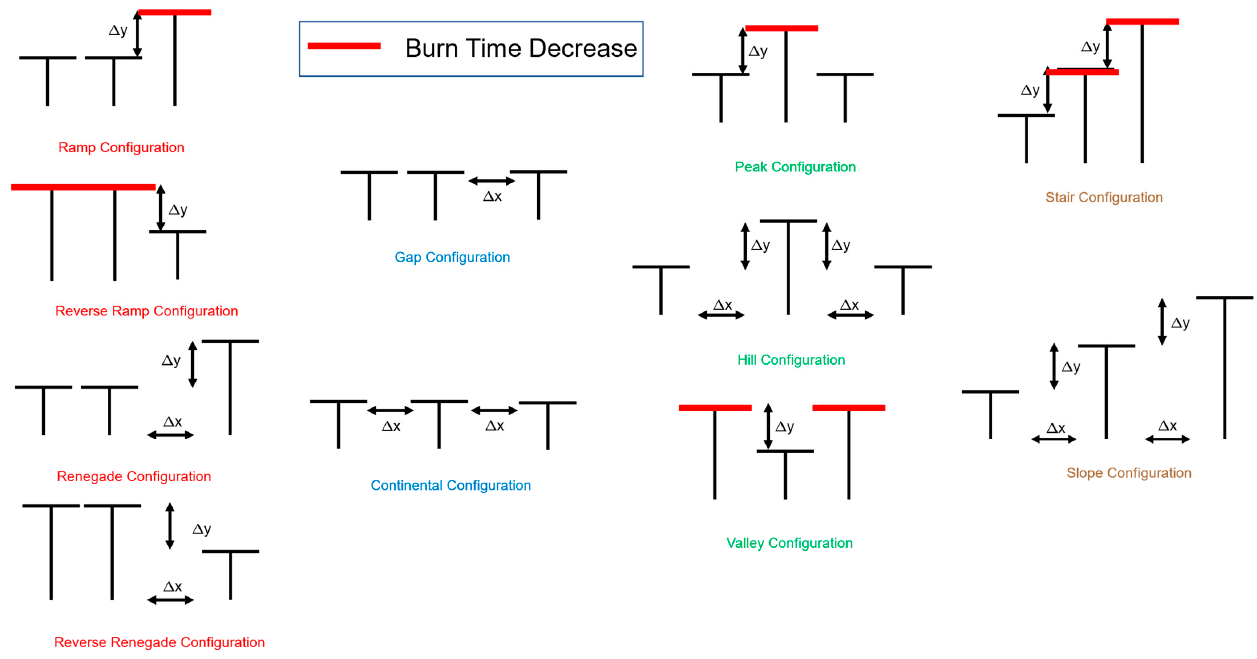
Figure 20. General three-pad configurations (repeated from Figure 2) with pads for which the burn times decreased due to flame merging highlighted.